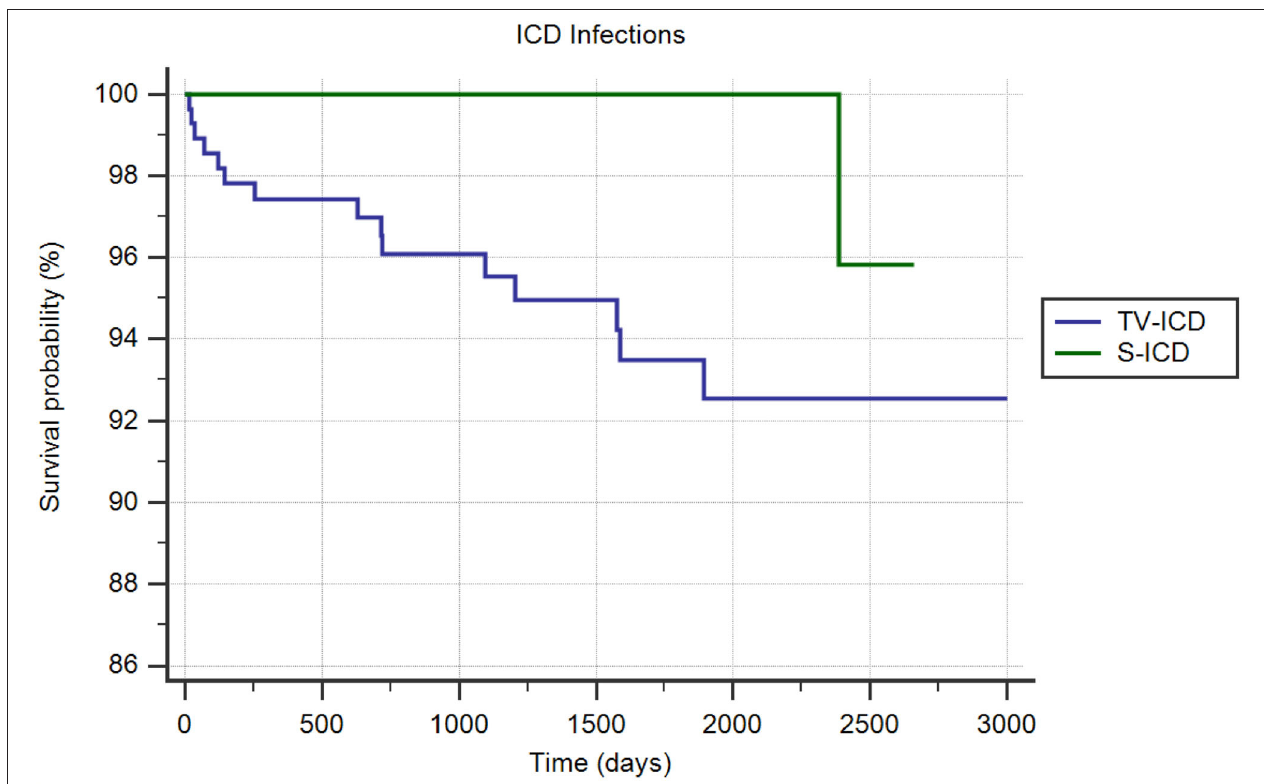
FIGURE 3 | Kaplan-Meier curve comparing survival without ICD infections among S-ICD vs. TV-ICD groups.